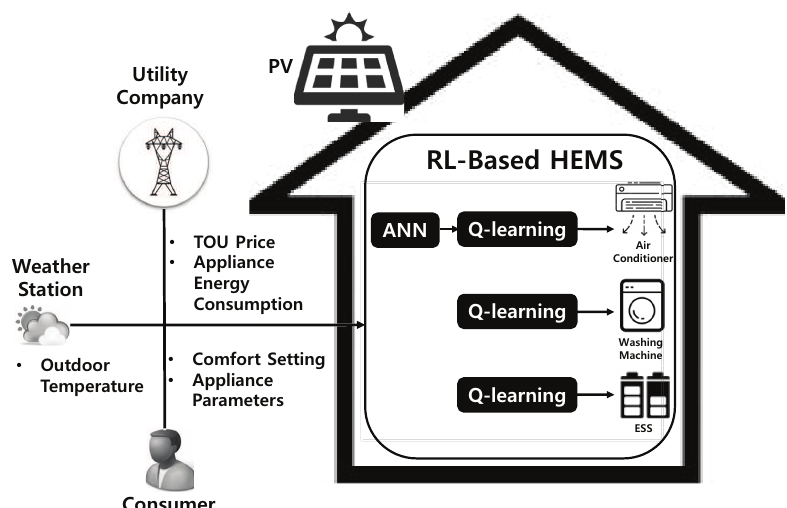
Figure 1. Illustration of the proposed home energy management system (HEMS)